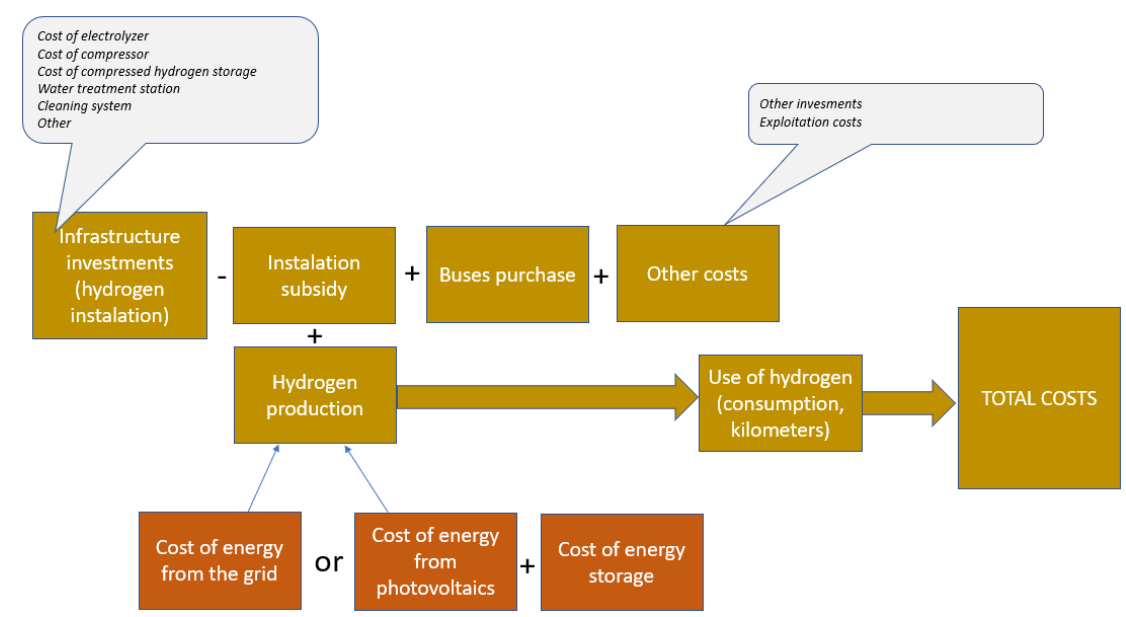
Figure 2. Total investment (with and without) costs without labor cost [own elaboration].